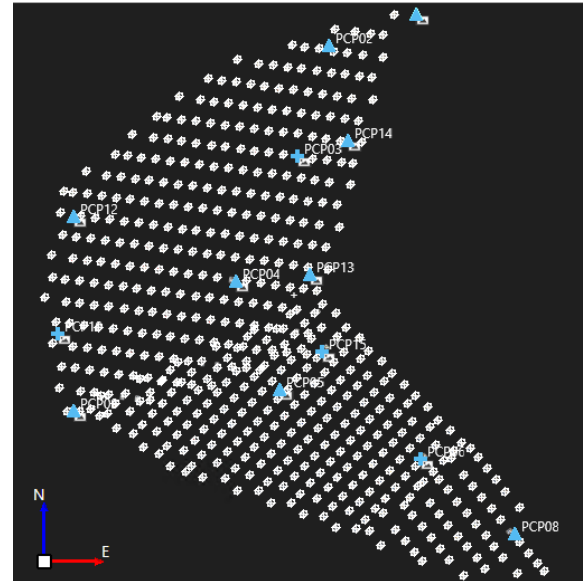
Figure 4 . Distribution of GCPs (light blue triangles) and CPs (light blue crosses) compared to images’ positions (white